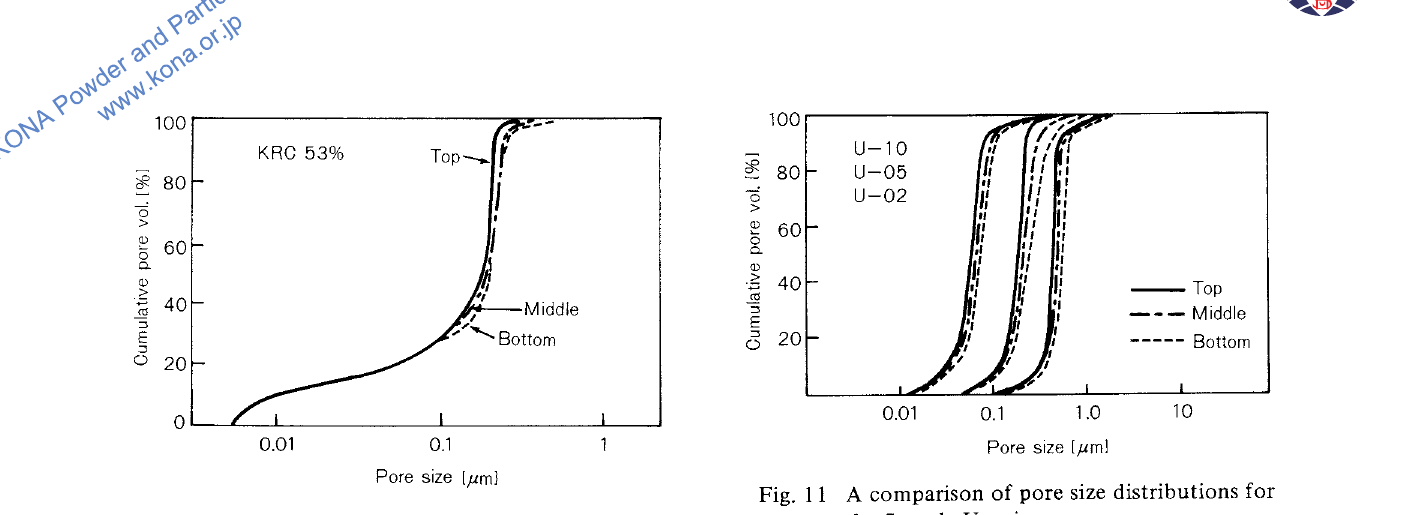
Fig. I 0 The pore size distribution of a compacted